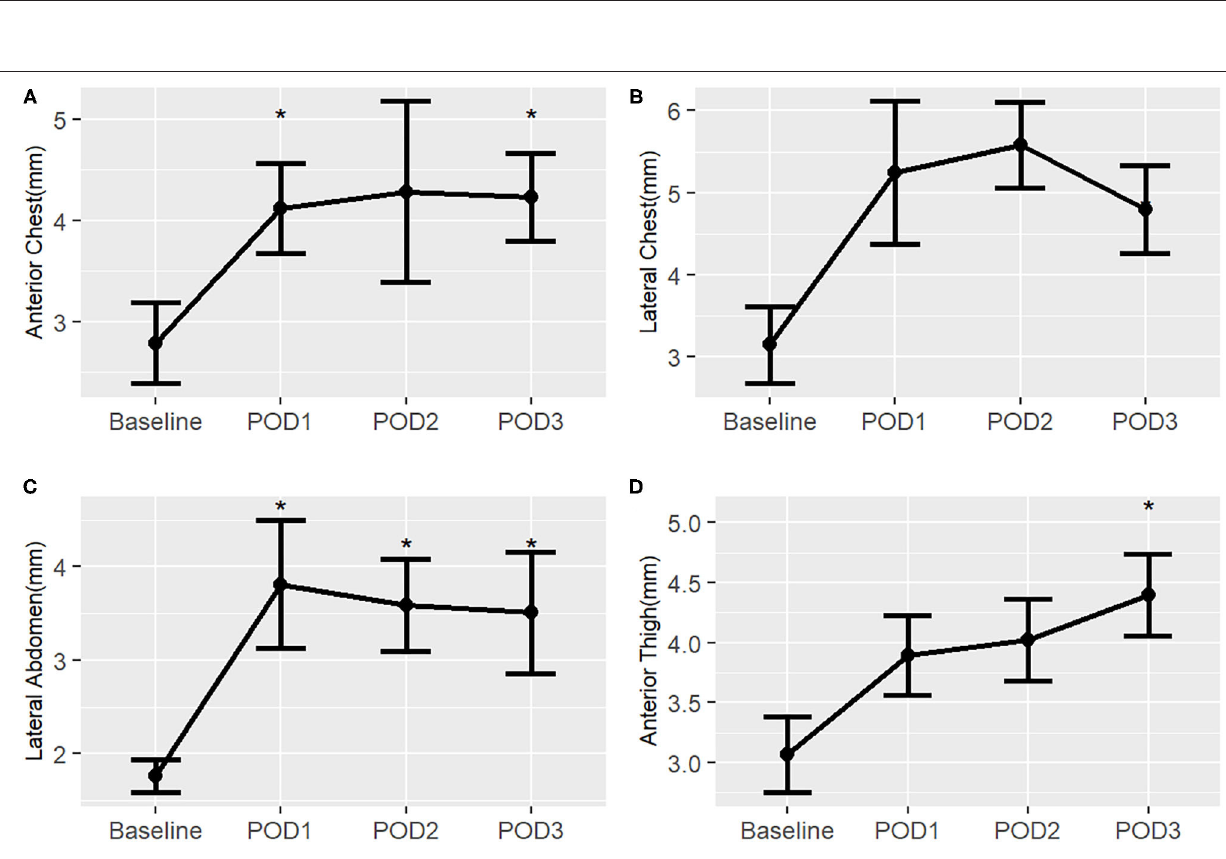
trend in post-operative infants. All surgical subjects developed edema by POD 1. This extravascular fluid overload began to improve in infants after POD 1 but persisted in neonates